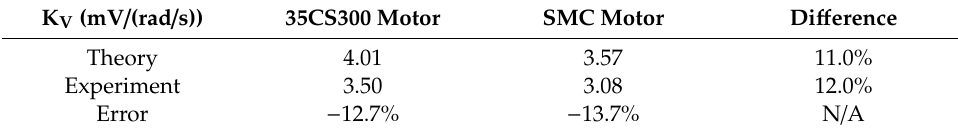
Table 7. Comparison of BEMF constants (K V ) of 35CS300 and Somaloy 700 1P motors.